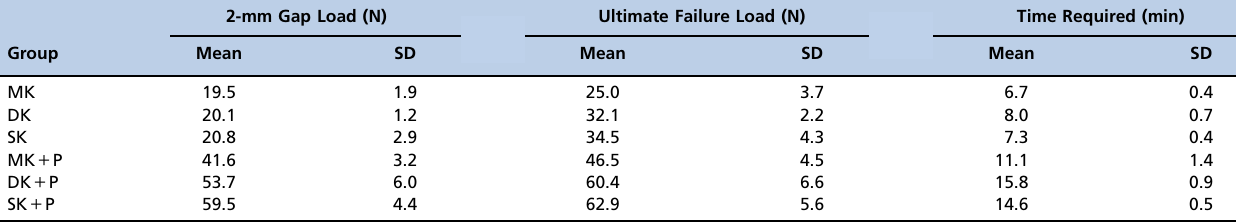
Table 1 - The 2-mm Gap Loads and Ultimate Failure Loads of the six suture techniques.